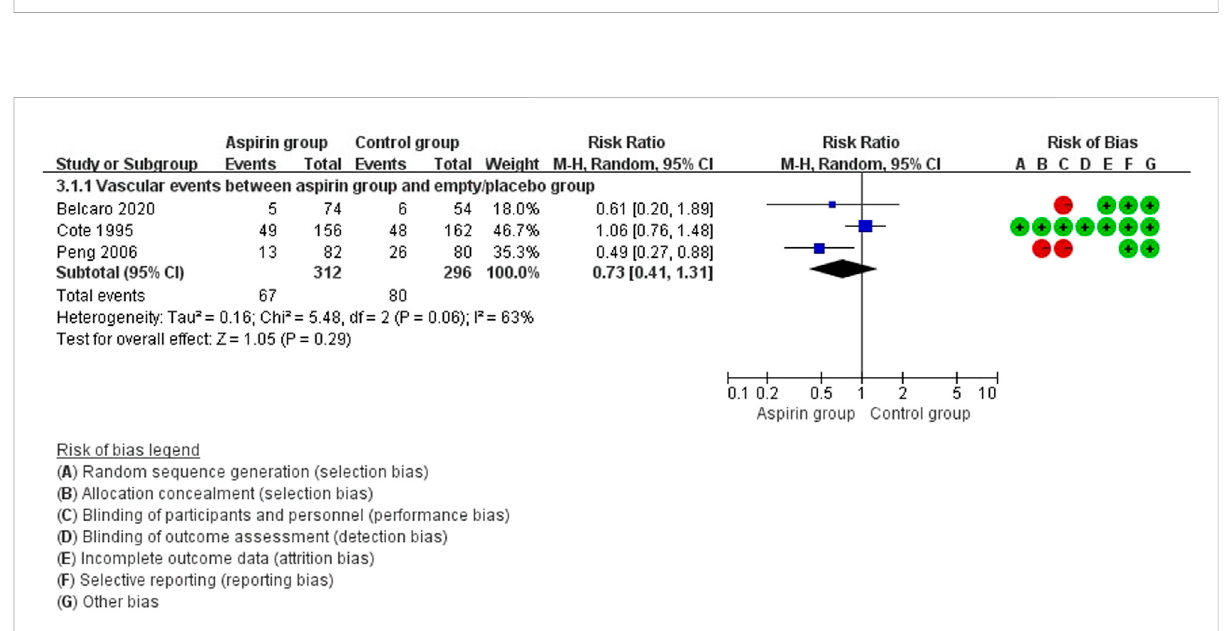
FIGURE 3 Forest plot of vascular events between the aspirin group and the control